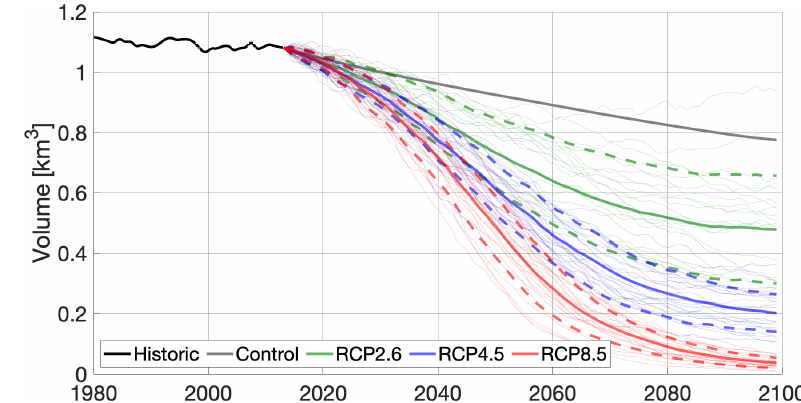
Figure 7. Ice volume evolution under the three scenarios RCP2.6 (green), RCP4.5 (blue), and RCP8.5 (red) until the year 2100. Thin lines show the 23 individual evolutions from different climate models, thick solid lines indicate their mean, and thick dashed lines indicate the mean plus and minus the standard deviation. The solid black line shows the evolution of the transient spin-up between 1979 and 2013, and the thick grey line shows a control run based on a zero-anomaly with respect to the reference period 2006–2020.